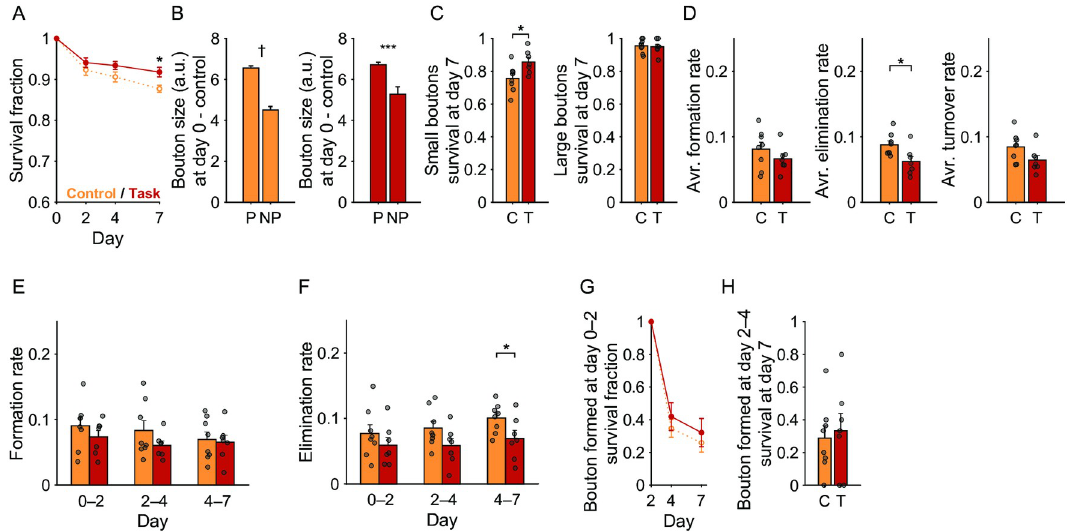
Fig 5. Dynamics and stabilization of thalamic boutons during motor learning. (A) Survival fraction of the pre-existing thalamic boutons up to day 7. Red, thalamic boutons in trained mice; orange, thalamic boutons in control mice. � p < 0.05. (B) The day 0 sizes of the pre-existing boutons that persisted until day 7 (P) and those that did not (NP). † p < 1 × 10 − 11 , ��� p < 0.001. (C) Day 7 survival rates of small and large pre-existing boutons. Those pre-existing boutons whose sizes belonged to the lower and upper third were defined as small and large boutons, respectively. C, control mice; T, trained mice. (D) The formation, elimination, and turnover rates averaged over days 0–2, 2–4, and 4–7. (E) Formation rate of thalamic boutons during days 0–2, 2–4, and 4–7. (F) Elimination rate